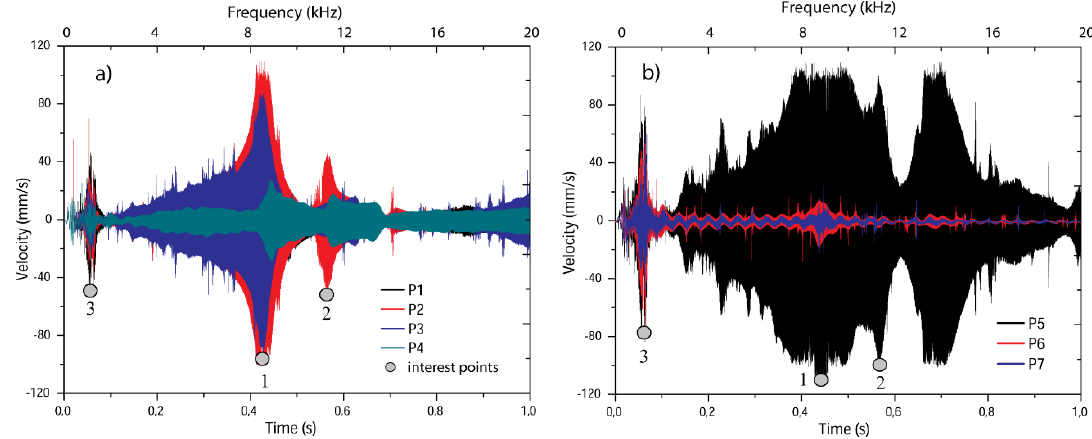
Figure 5. Velocity measurements. ( a ) Piezoelectric patch (P1, P2, P3, P4). ( b ) Wire and mass (P5, P6, P7).